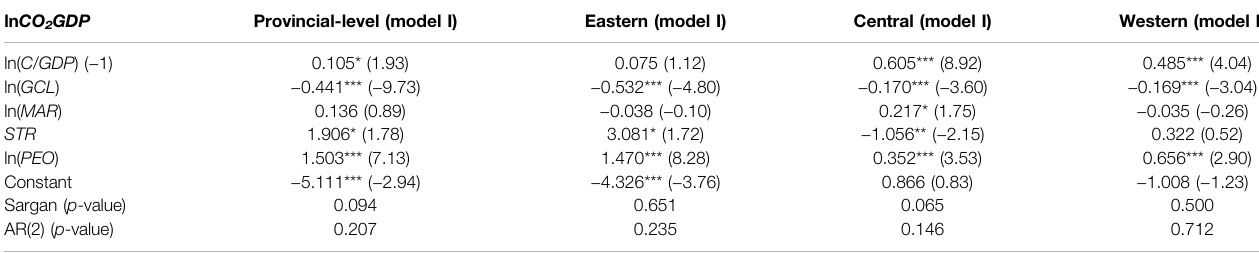
TABLE 2 | The in fl uence of green credit based on system GMM on carbon emission. ln CO 2